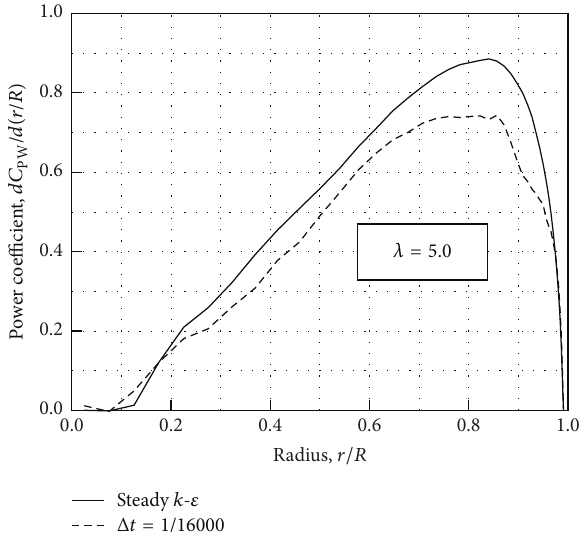
Figure 7: Local power coefficient for tip speed ratio 𝜆 = 5 .